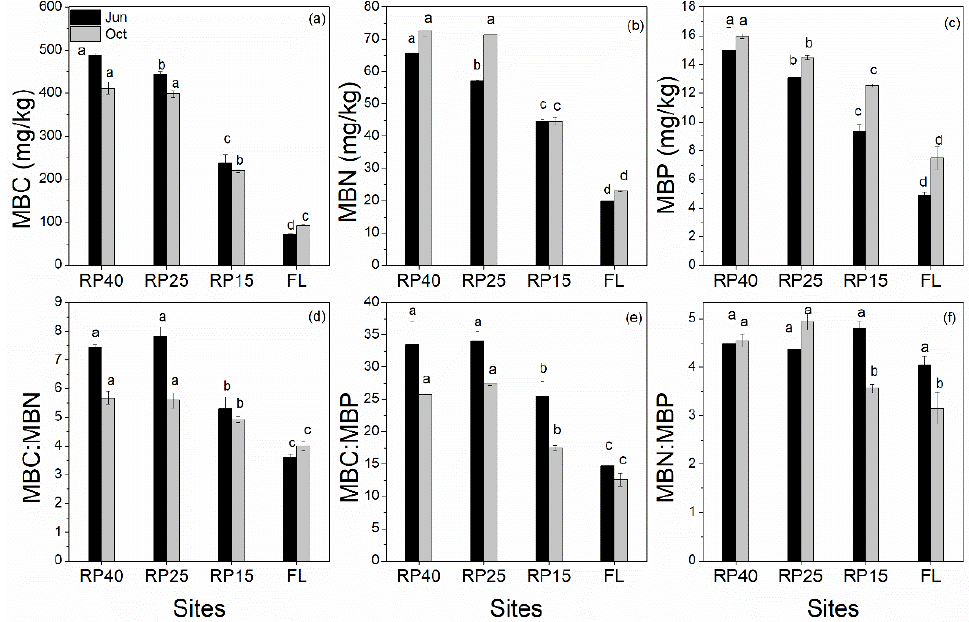
Figure 5. Soil microbial C ( a ), N ( b ), P ( c ) and soil MBC: MBN ( d ), soil MBC: MBP ( e ) and soil MBN: MBP ( f ) after afforestation. Different letters denote significant ( p < 0.05) differences among sites in same month and error bar represents standard error. Note: 40, 25, and 15 years of Robinia pseudoacacia L. indicated as RP40, RP25, and RP15.